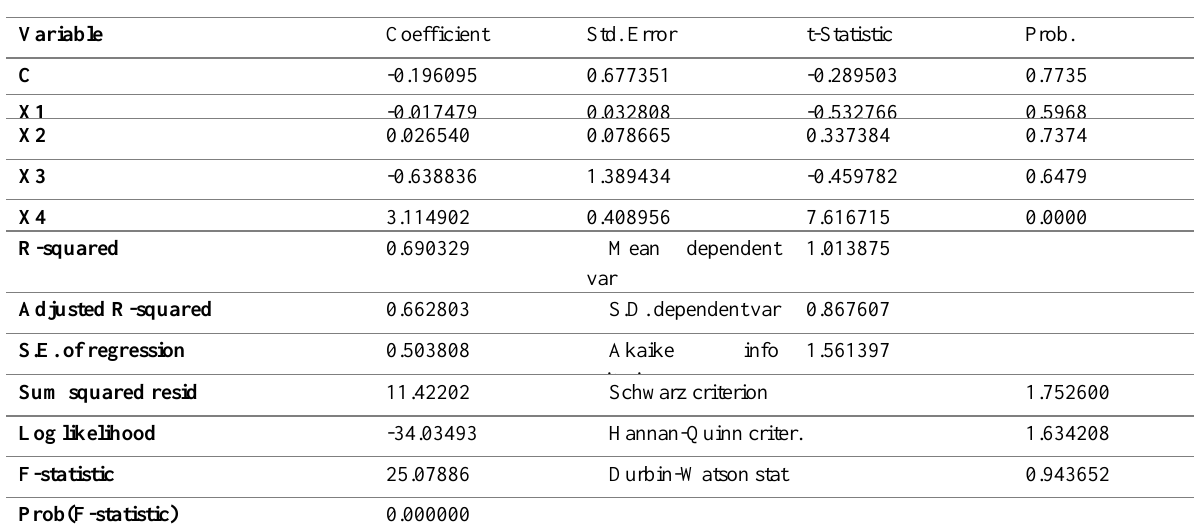
Table 5: Results of Multiple Regression